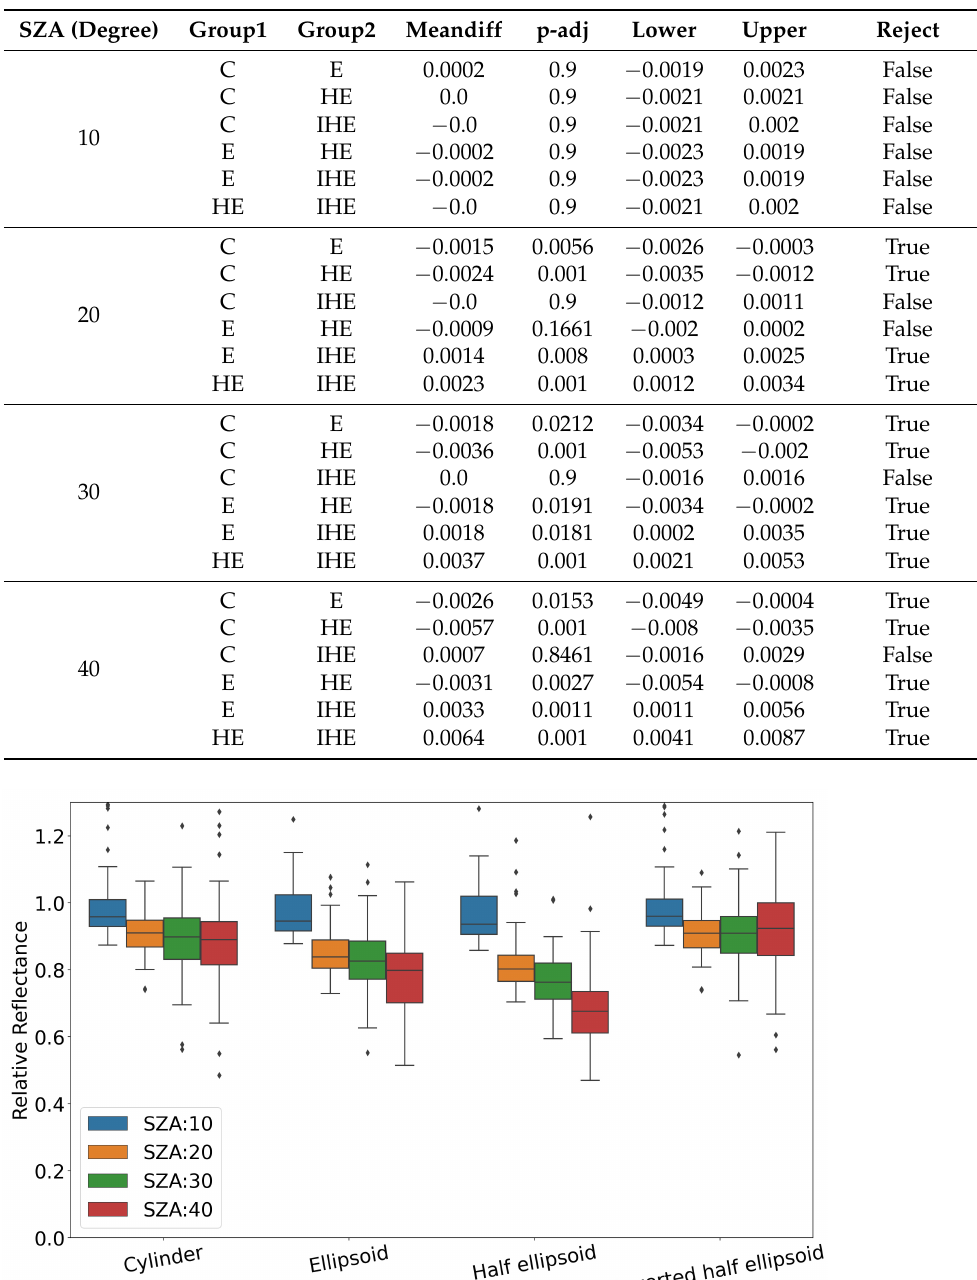
Table 4. Multiple comparisons using Tukey’s HSD test for reflectance simulation results for different canopy shapes in each SZA (C: cylinder, E: ellipsoid, HE: half ellipsoid and IHE: inverted half ellipsoid). p value is 0.05.